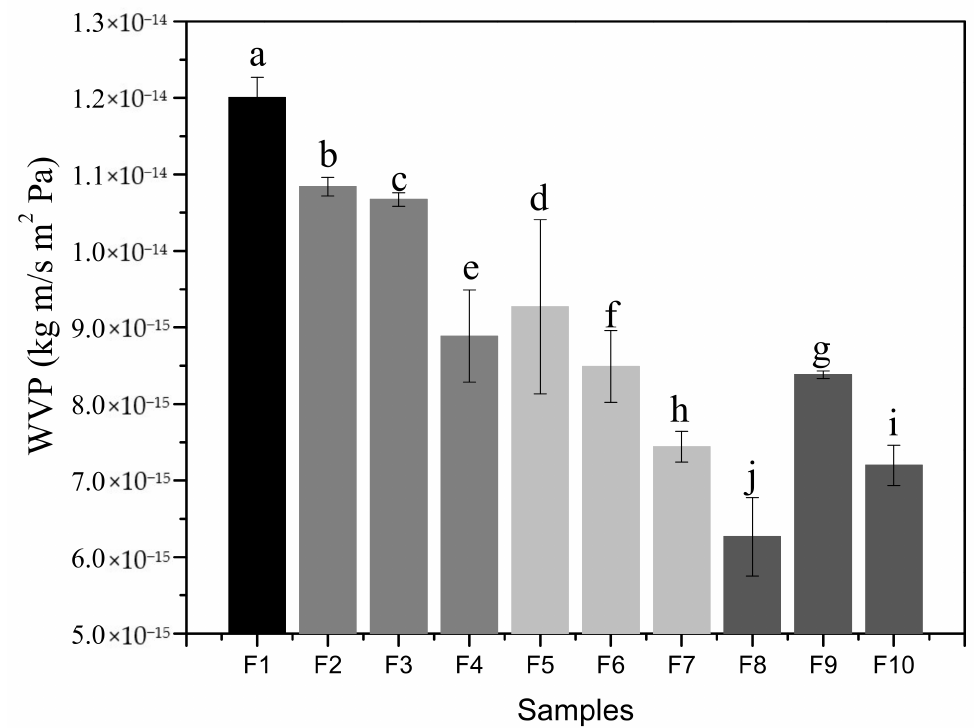
Figure 6. Barrier properties of the reinforced gelatin biofilms. Different letters indicate statistically significant differences ( p < 0.05) between the biofilms ( n = 3). F1: control sample; F2–F4: samples with microfiber; F5–F7: samples with bentonite; F8–F10: samples with microfiber and